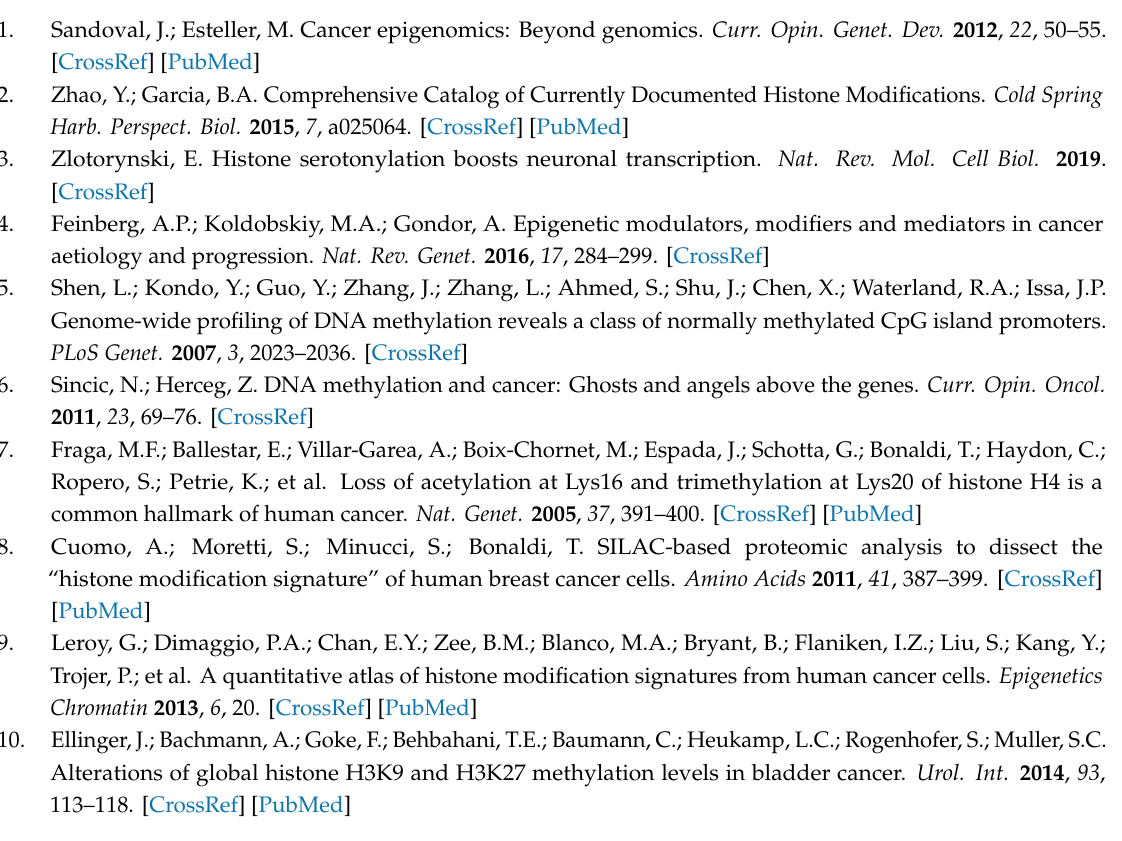
Table S2: Summary of ovarian cancer samples; Table S3: Summary of head and neck samples; Table S4: Summary of prostate cancer samples; Table S5: Summary of cell lines used. Excel files—Dataset S1: AUC values for the normal / tumor samples analyzed; Dataset S2: AUC values for cells synchronized in di ff erent phases of the cell cycle; Dataset S3: mutation analysis of